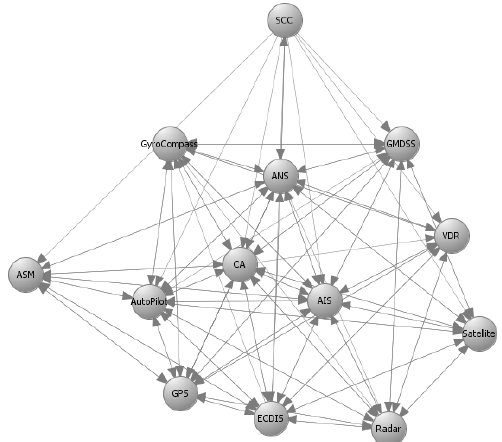
Figure 5. Remotely controlled ship—Navigational CPSs– G (cid:48)